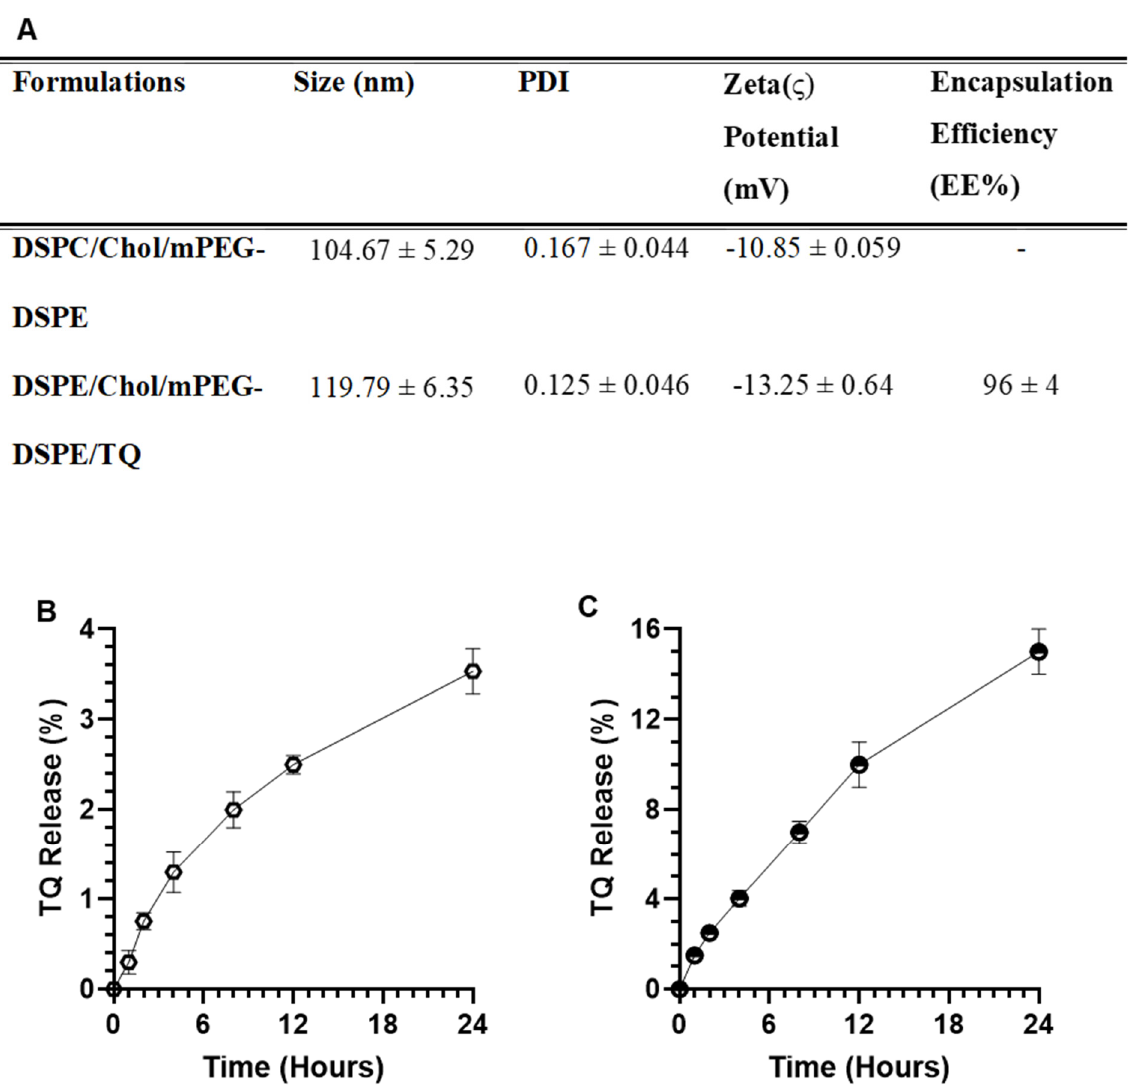
Figure 5. Characterization and in vitro stability and release kinetics of PEG-Lip-TQ. ( A ) size, PDI, Zeta Potential, and Entrapment Efficiency. ( B ) Stability of PEG-Lip-TQ in PBS. ( C ) Release kinetics of TQ from the liposomes into the serum. The values are expressed as mean ± SE of three independent experiments.